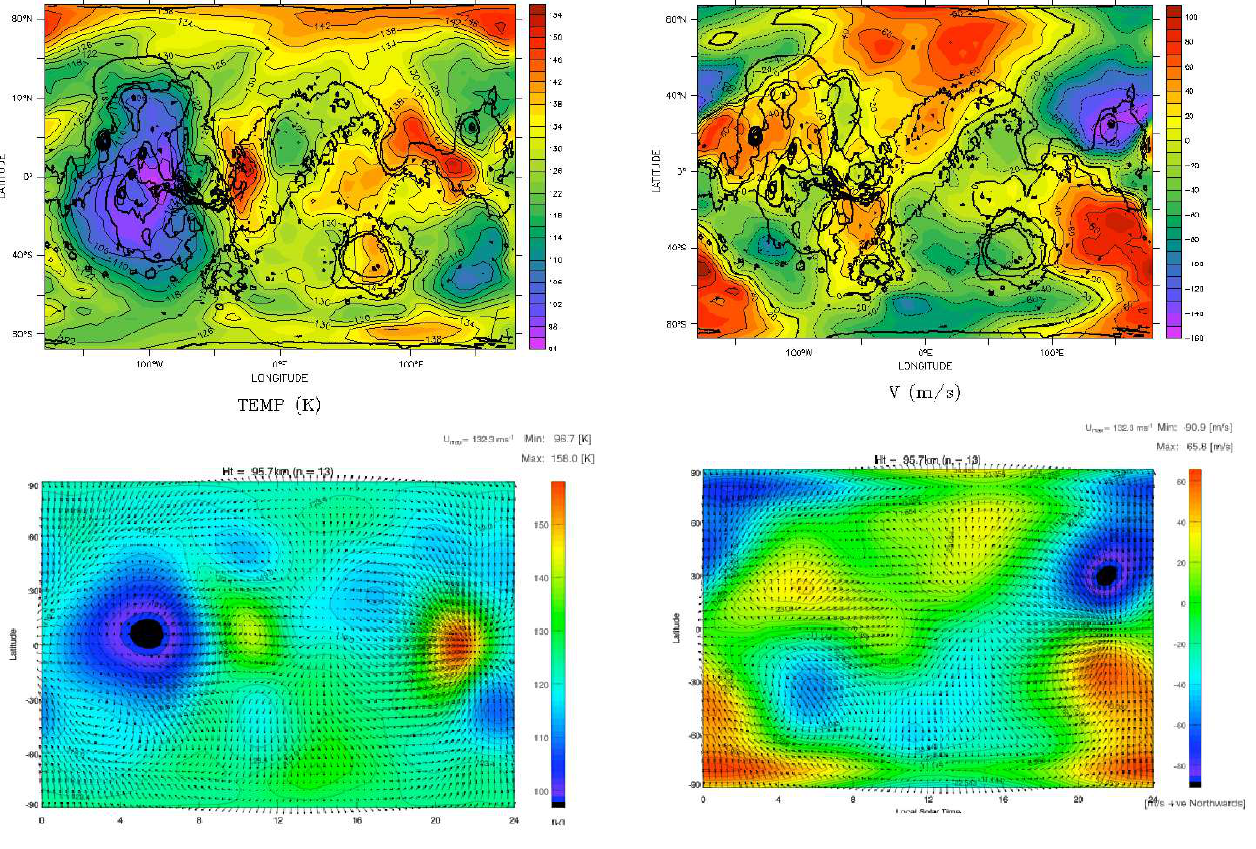
Fig. 11. Thermospheric temperature structures at pressure level 13 (pressure=2.188 × 10 − 3 Pa), from MCD (top) and MarTIM+MCD (bottom).